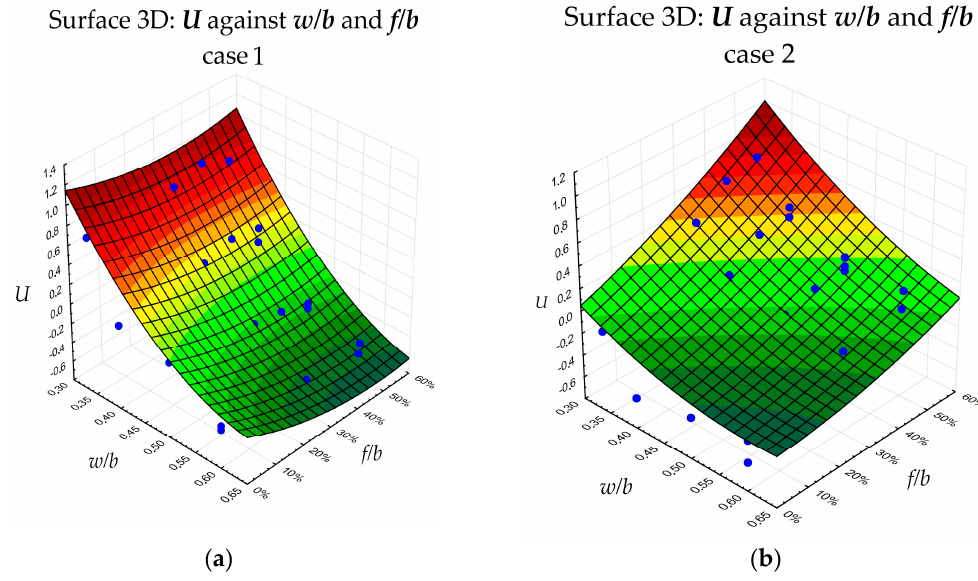
Figure 3. Utility of concrete with siliceous fly ash in function of w / b and f / b : ( a ) weight case 1; ( b ) weight case 2.